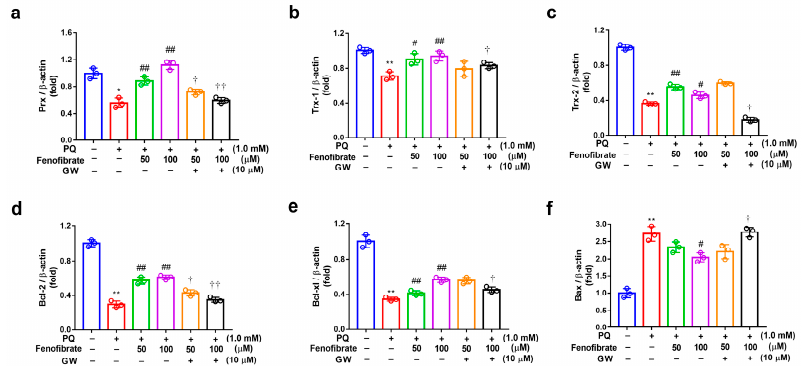
Figure 5. mRNA expression of peroxiredoxin (Prx), thioredoxin-1 (Trx-1), Trx-2, B-cell lymphoma 2 (Bcl-2), Bcl-xl, and B-cell lymphoma 2-associated X protein (Bax) in RF/6A cells detected using